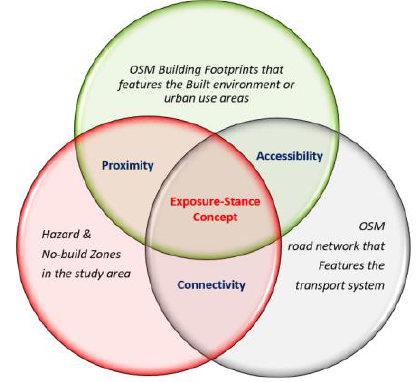
Figure 1. Exposure-Stance Concept